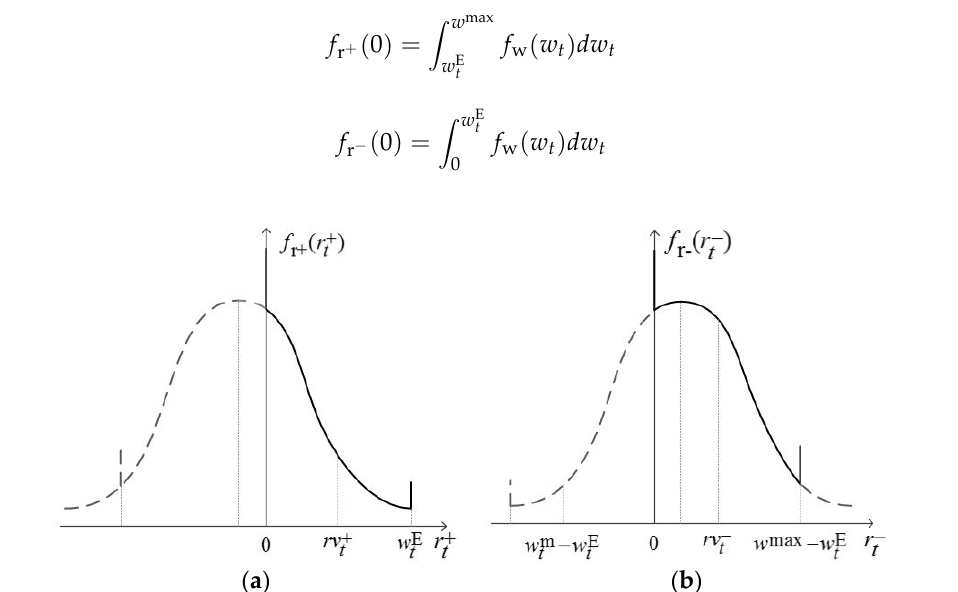
( r + ) and f ( r − ) should be truncated at their left boundaries because Figure 4a,b. The functions f r + r − t t ≥ 0 and r − ≥ 0, the probability density of which is amended as Equations (3) and (4), respectively. r + t t